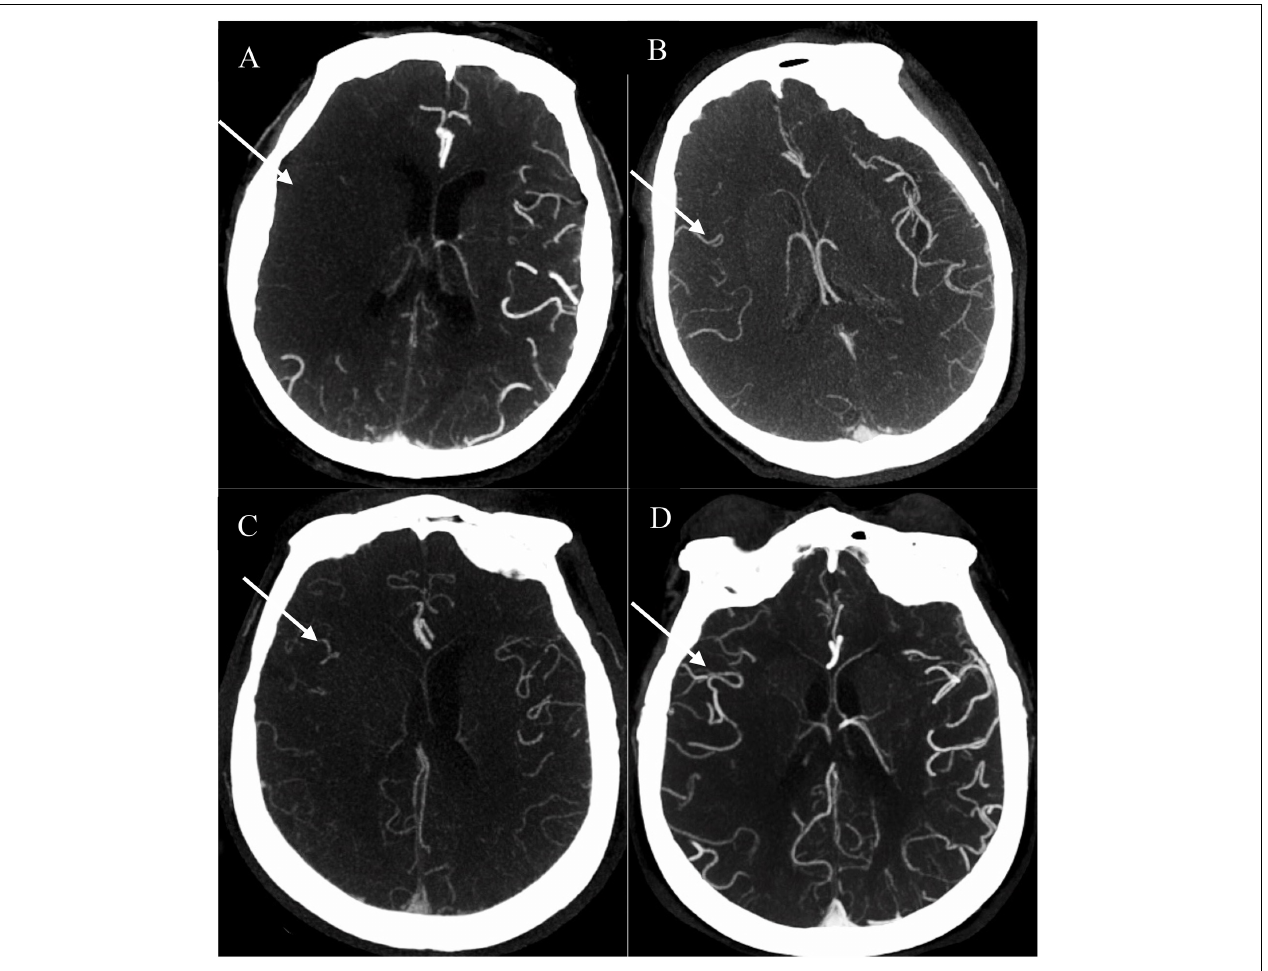
FIGURE 1 | Examples of collateral circulation from 0 to 3 (white arrow). (A) 0 = absent collateral, (B) 1 = collateral filling < 50% of the occluded territory, (C) 2 = collateral filling > 50% < 100% of the occluded territory, and (D) 3 = collateral filling 100% of the occluded territory. All four patients were acute ischemic stroke (AIS) with right middle cerebral artery (MCA)-M1 occlusion. AIS, acute ischemic stroke; MCA, middle cerebral